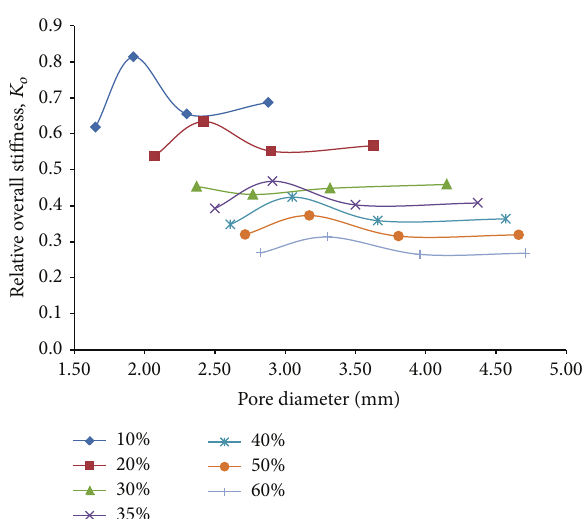
Figure 14: Plots depicting variation of relative overall stiffness, 𝐾 𝑜 , against pore diameter for different percentages of porosity of 3D porous FE cantilever beam models subjected to combined loading action.